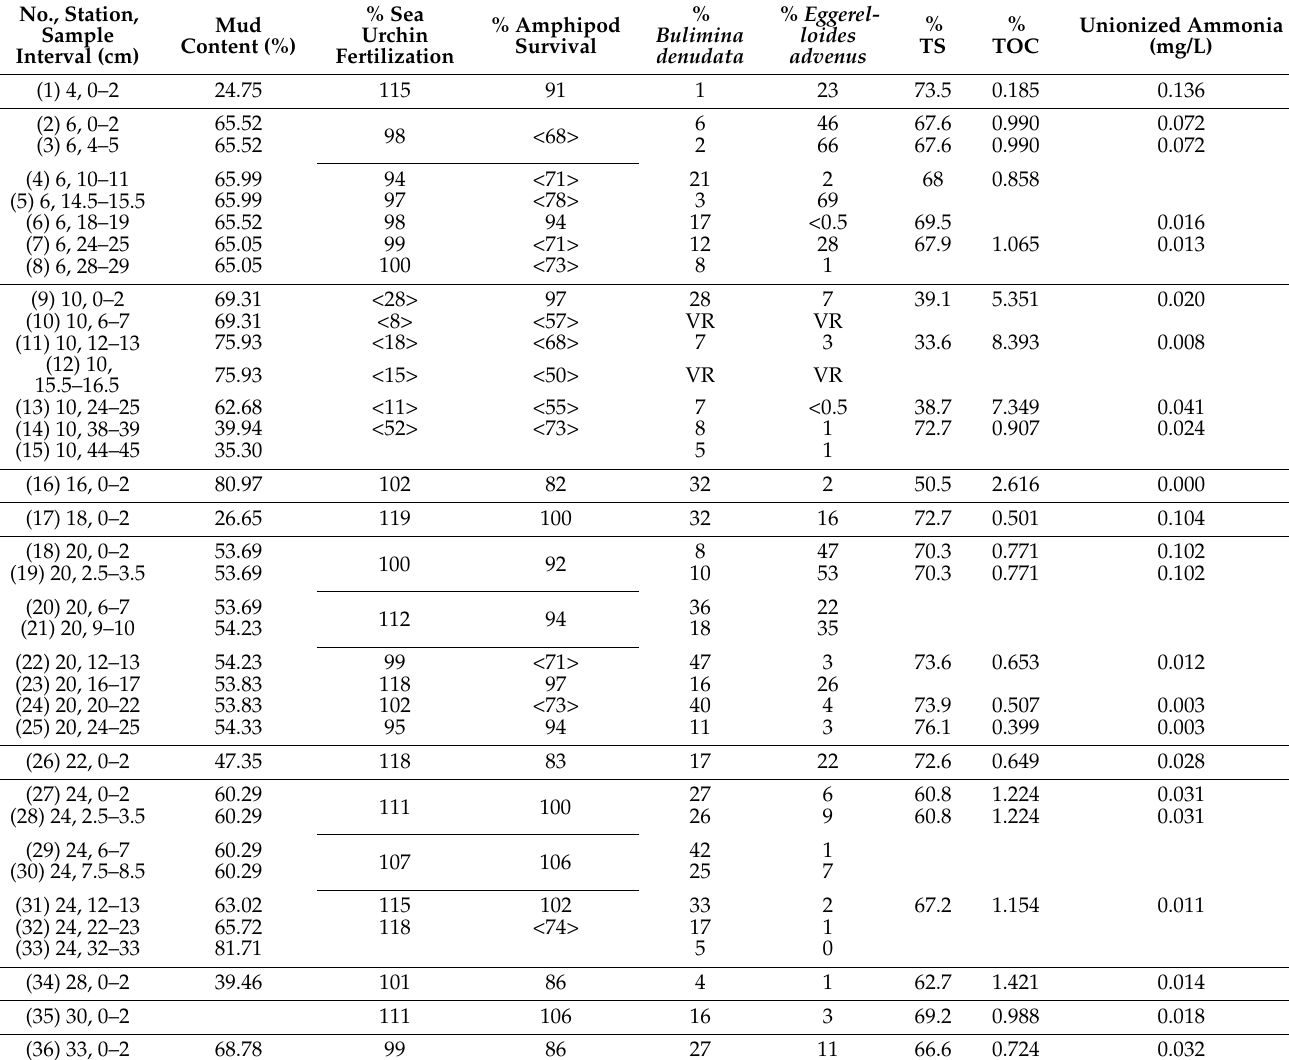
Table A1. Samples (station and sample interval in cm), mud content (% mud), sea urchin fertilization success (% of control), amphipod survival (% of control), percent abundances of Bulimina denudata and Eggerelloides advenus , total solids (% TS), total organic carbon (% TOC), unionized ammonia, and sediment concentrations of trace metals and trace organic compounds in the 1997 surface and downcore Santa Monica Bay samples. Samples that were toxic based on percent sea urchin fertilization success and percent amphipod survival are in angle brackets. Sediment concentrations exceeding the ERL guidelines are in parentheses; sediment concentrations exceeding the ERM guidelines are in square brackets and bold. VR = very rare foraminifera recovered (sample not statistically valid; see Core 10), As = arsenic, Be = beryllium, Cd = cadmium, Cr = chromium, Cu = copper, Pb = lead, Hg = mercury, Ni = nickel, Ag = silver, Zn = zinc, Fe = iron, total DDT = total dichlorodiphenyltrichloroethane, total PCBs = total polychlorinated biphenyls, and total PAHs = total polycyclic aromatic